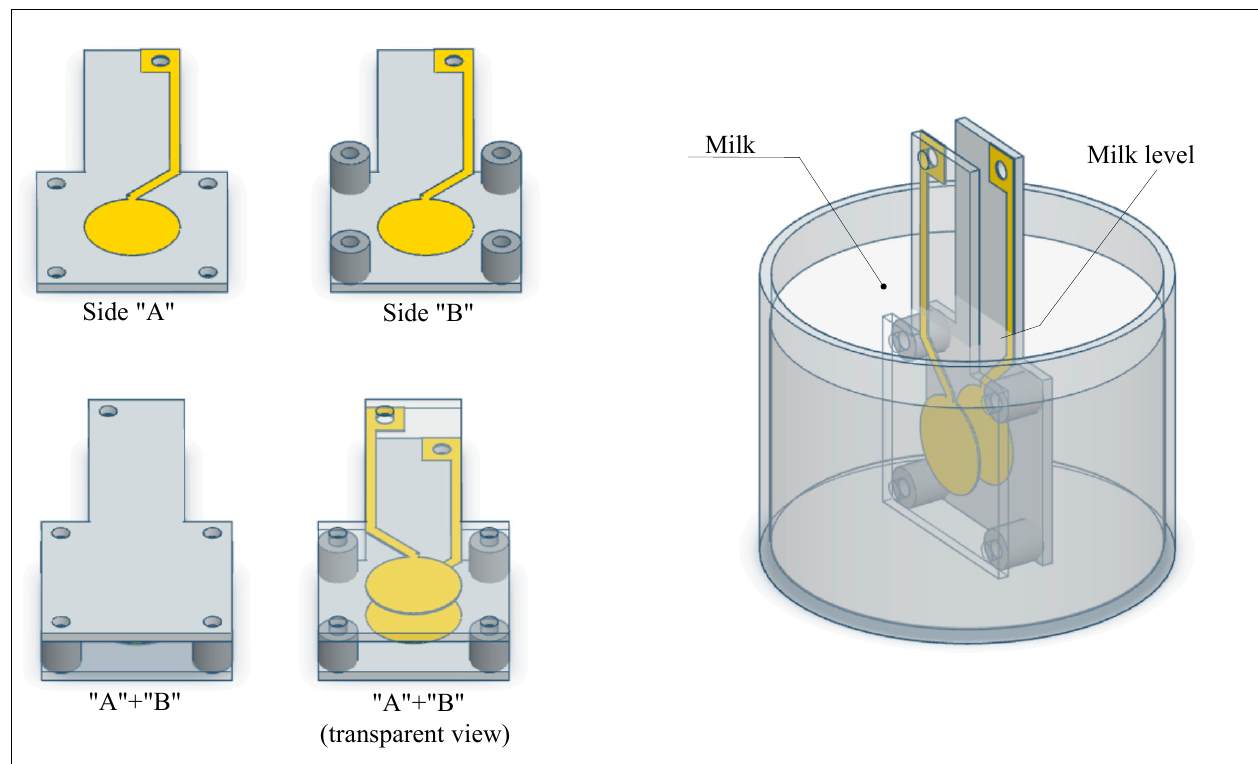
Figure 2. Schematic of the assembly of the electrodes and their positioning inside the sample holder. The overlap of the electrodes is performed in such a way as to minimize parasitic capacitive couplings above the milk level.